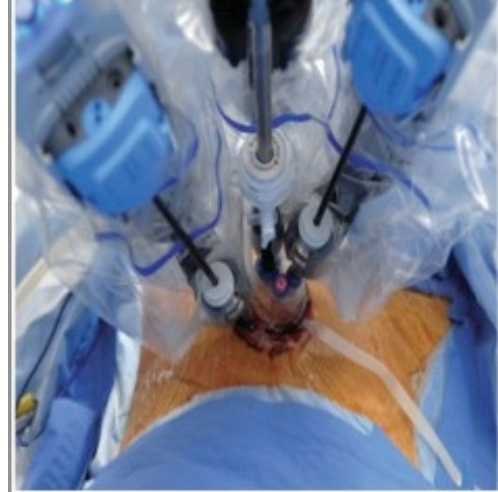
Figure 2. R-LESS set up.